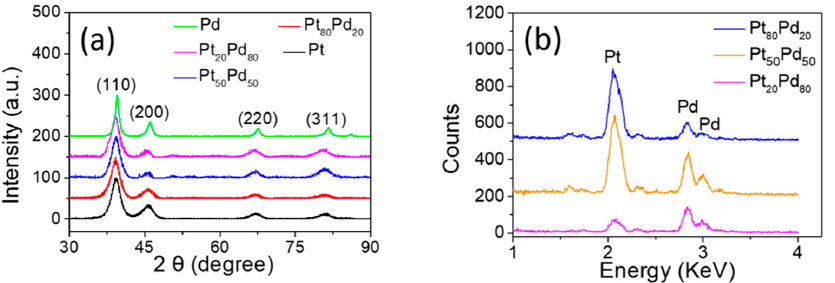
Figure 2. ( a ) XRD spectra of Pt x Pd y bimetallic and Pt, Pd monometallic aerogels. ( b ) TEM–EDS of Pt 80 Pd 20 , Pt 50 Pd 50 , and Pt 20 Pd 80